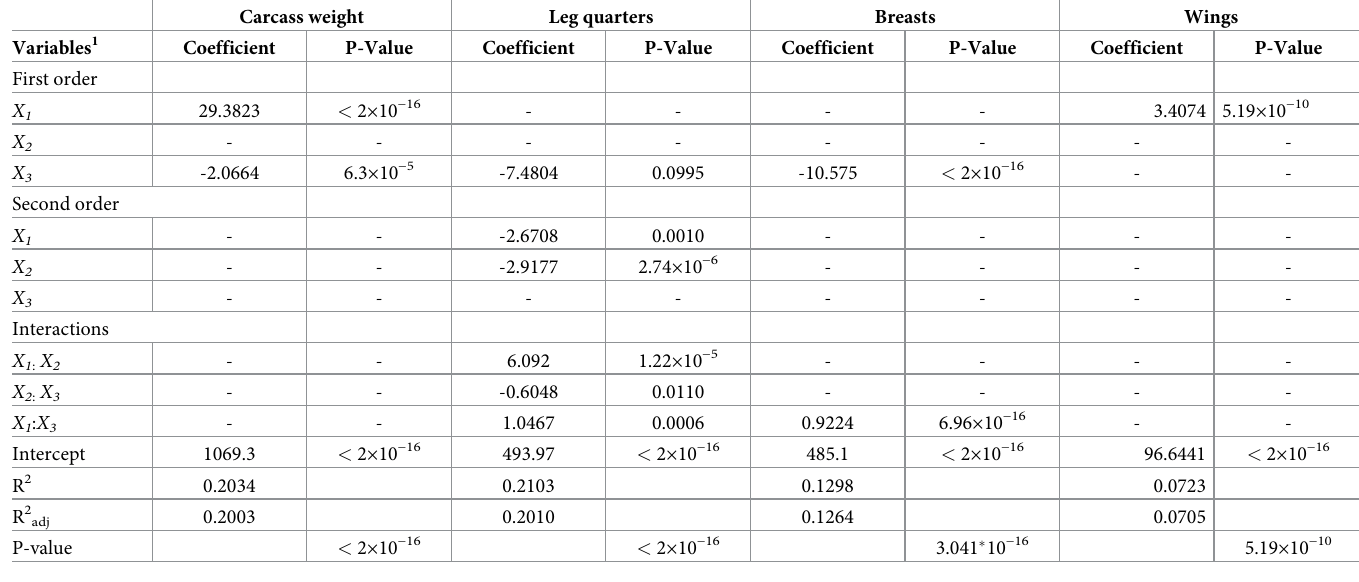
Table 8. ANOVA, coefficient estimates and summary statistics of carcass traits (g/bird) in response to digestible lysine concentration (SID Lys), energy density (AMEn) and starch to lipid ratios (S:L) in broiler chickens. Carcass weight Leg quarters Breasts